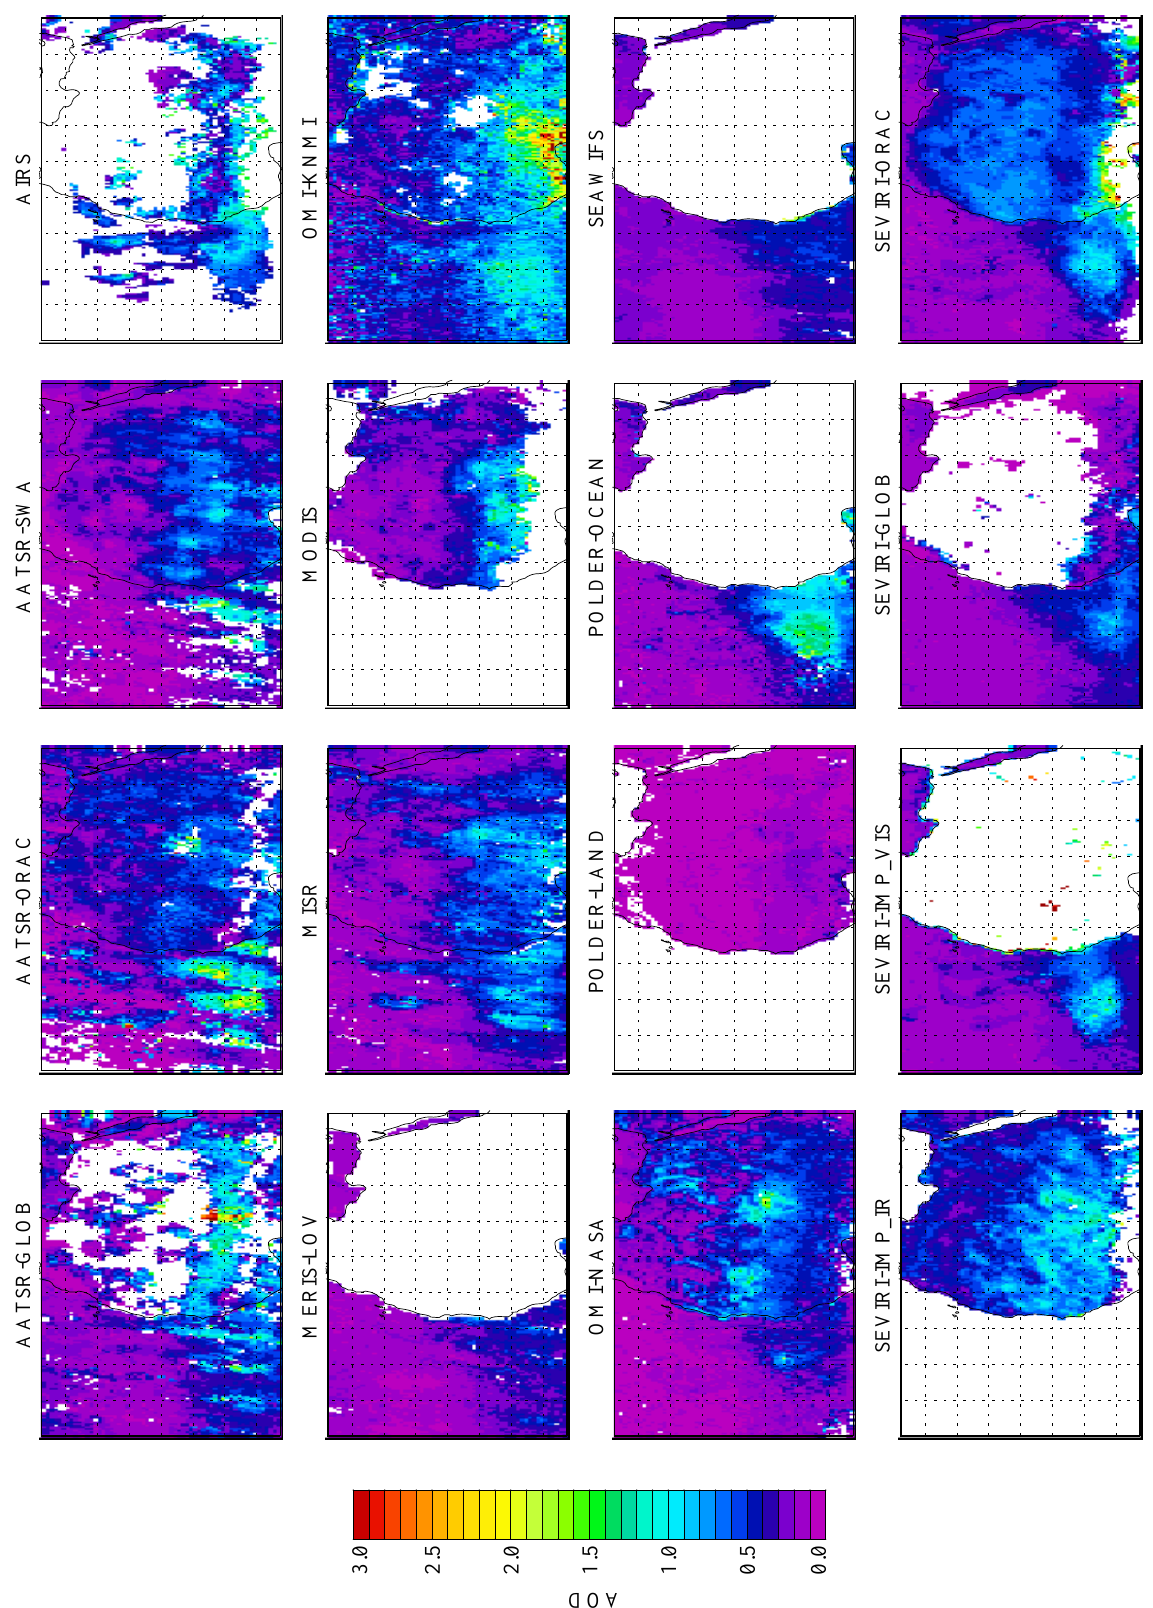
Fig. 2. Image of monthly mean AOD of the different datasets for March